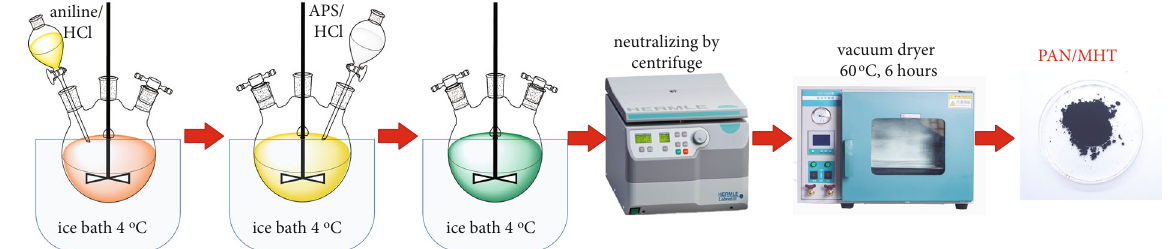
Figure 2: Schematic illustration of synthesis steps for